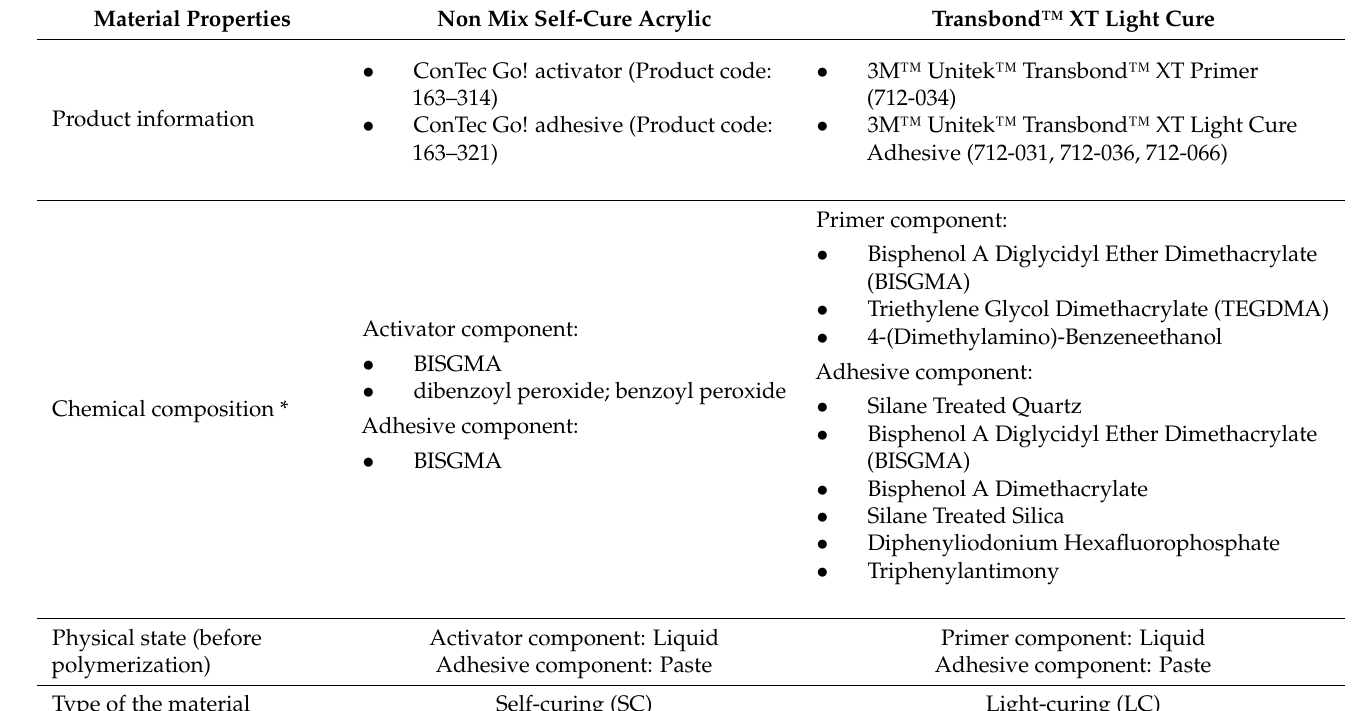
Table 1. Properties of examined